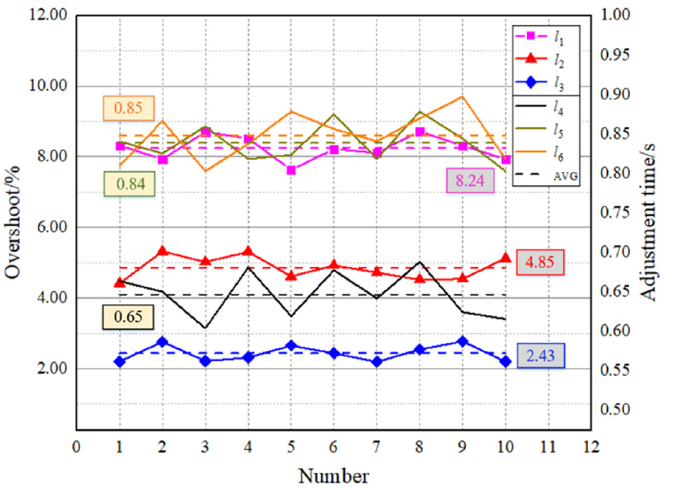
Figure 13. Change curve of overshoot and adjustment time of repeatability test during ascending motion.